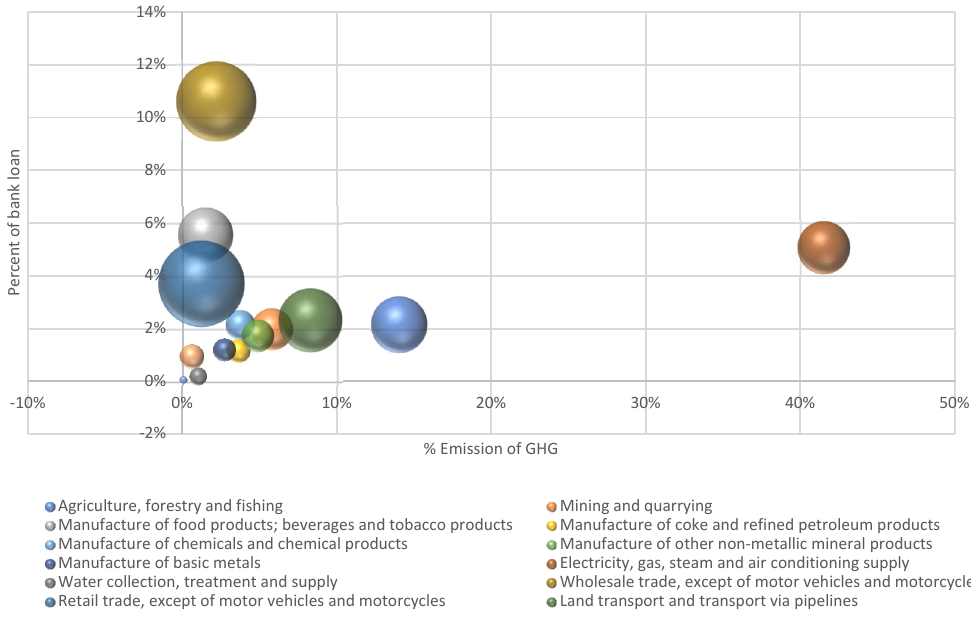
Figure 6. Corporate structure liabilities: emitting sectors versus other sectors. Commercial and cooperative banks have relatively significant exposure to enterprises operating in emission industries. The portfolio of emitter entities accounts for approxi- mately 40% of the commercial banking exposure of non-financial enterprises and 44% for the cooperative banking sector. However, it is worth noting that the scale of exposure to emitting entities is not the same as banks’ exposure to climate risk. The analysis of the impact of climate risk on the financial system requires the use of more fine-grained data. Commercial bank exposures to the energy sector prove to be more risky (Figure 7). The above-mentioned risk for banking industry could be reduced by a significant proportion of short-term loans—most corporate loans are repaid within 2–3 years, which leaves some freedom for the banking sector in shaping exposure to climate risk and (partial) transition to “green” projects at the expense of “brown”.